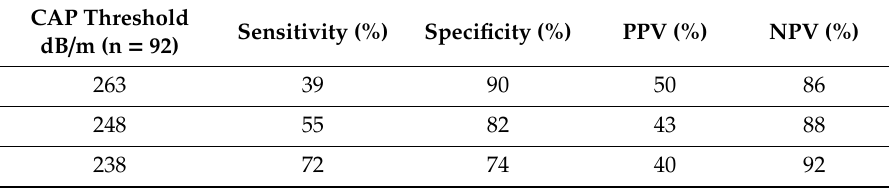
Table 4. Sensitivity analysis of the HSI ( > 41) versus CAP at di ff erent thresholds. CAP Threshold Sensitivity (%) Specificity (%) PPV (%) NPV (%) dB / m (n = 92) 263 248 55 82 43 88 238 72 74 40